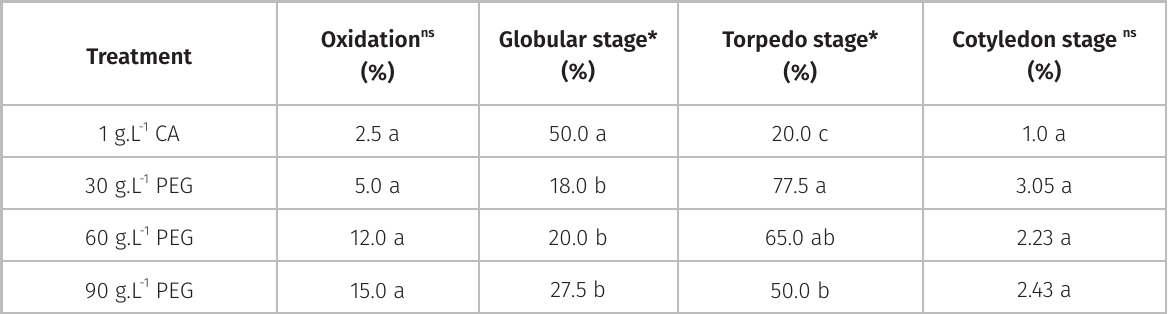
Table II. Effect of polyethylene glycol (PEG-4000) and activated charcoal (AC) on the somatic embryo formation in embryogenic masses from Plinia cauliflora seeds after 30 days in culture.